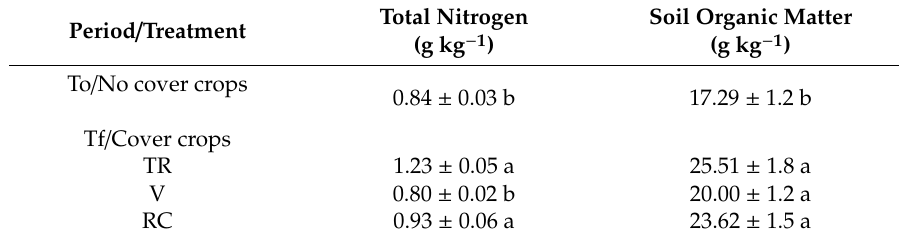
Table 4. Soil management e ff ect on total nitrogen and soil organic matter. (Values are means ±